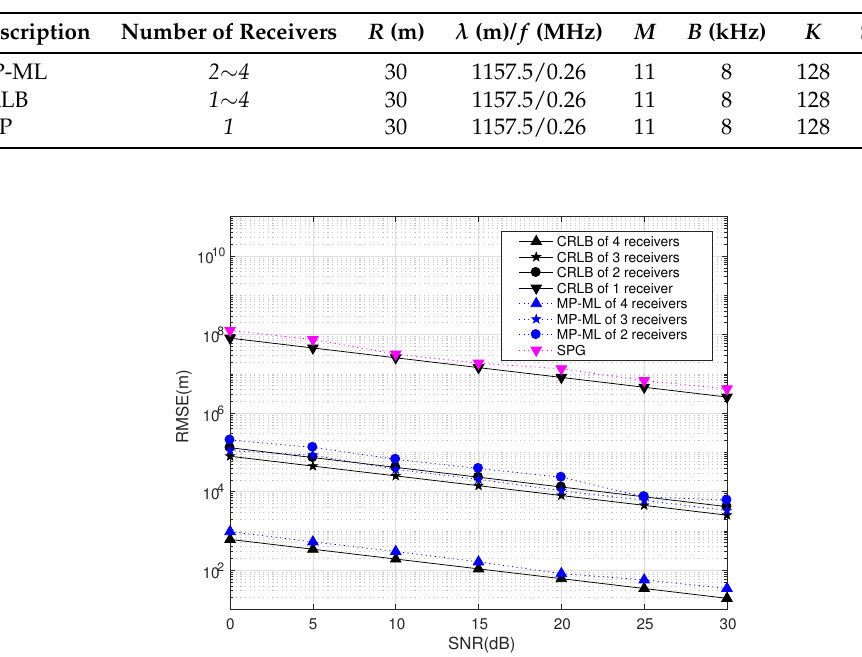
Table 7. Parameter setting in simulations of different numbers of receivers. SGP, Single Platform Geolocation .